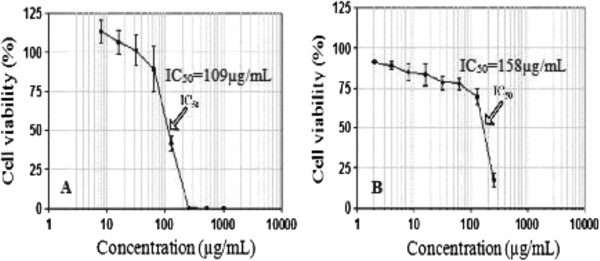
Cell viability of 3T3-A31 fibroblasts exposed to different concentrations of fresh xylem sap of
H. courbaril
(A) and of fisetin (B).